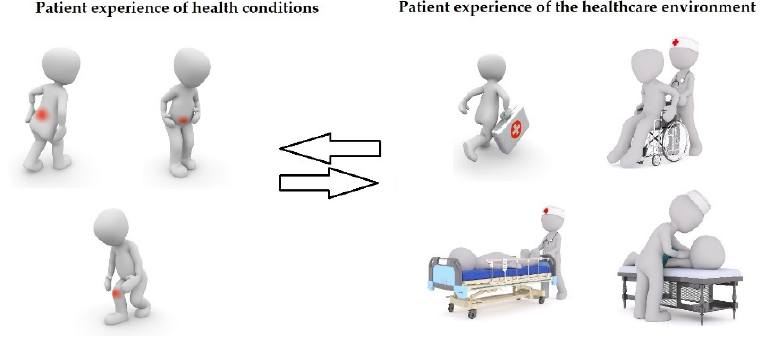
Figure 1. Patient experiences in a broad and a narrow sense.